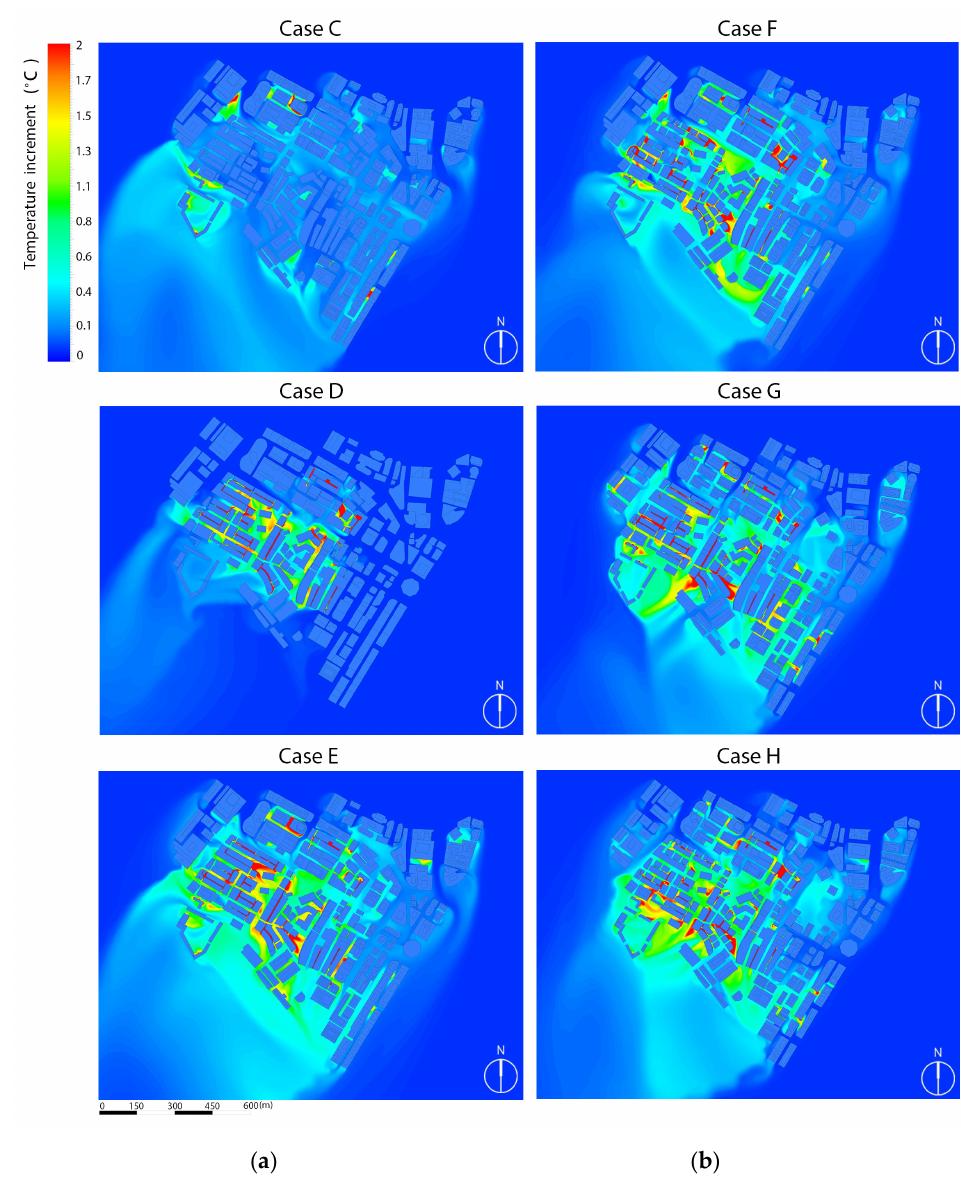
Figure 8. Wind speed contours of Case A ( left ) and Case B ( right ) at the study area (buildings high- lighted as red are the historic shophouses conserved at the Chinatown area).